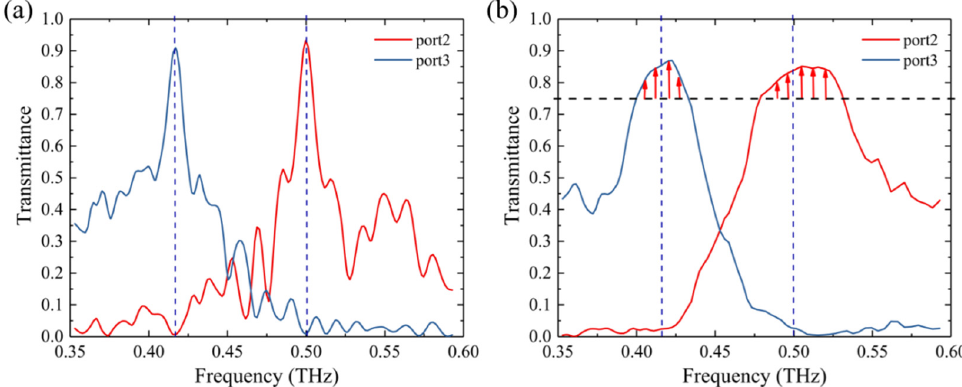
Figure 4. Transmittance curves of the two-port demultiplexer before ( a ) and after ( b ) bandwidth optimization.